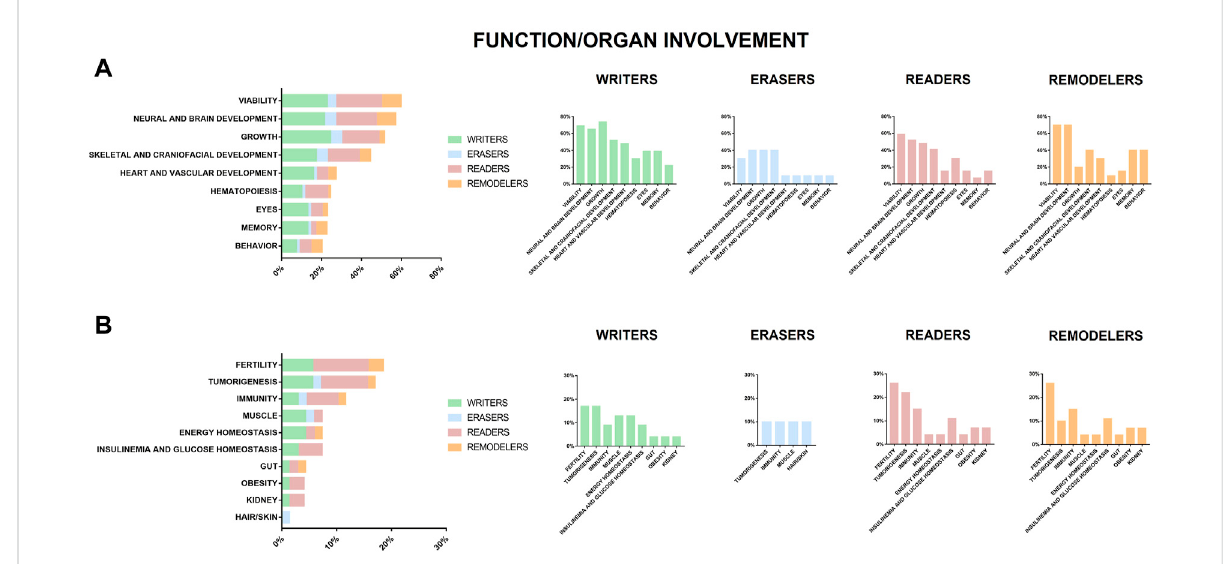
FIGURE 3 Function or organ found impaired or altered in animal models of chromatinopathies. Genes coding for writers (green), erasers (blue), readers (pink)andremodelers(orange), forwhichhaploinsuf fi ciencyresultsinhumanabnormalities. (A) reportsfunctions/organsinanimalmodelsalteredin more than 20% of analyzed genes and (B) those in <